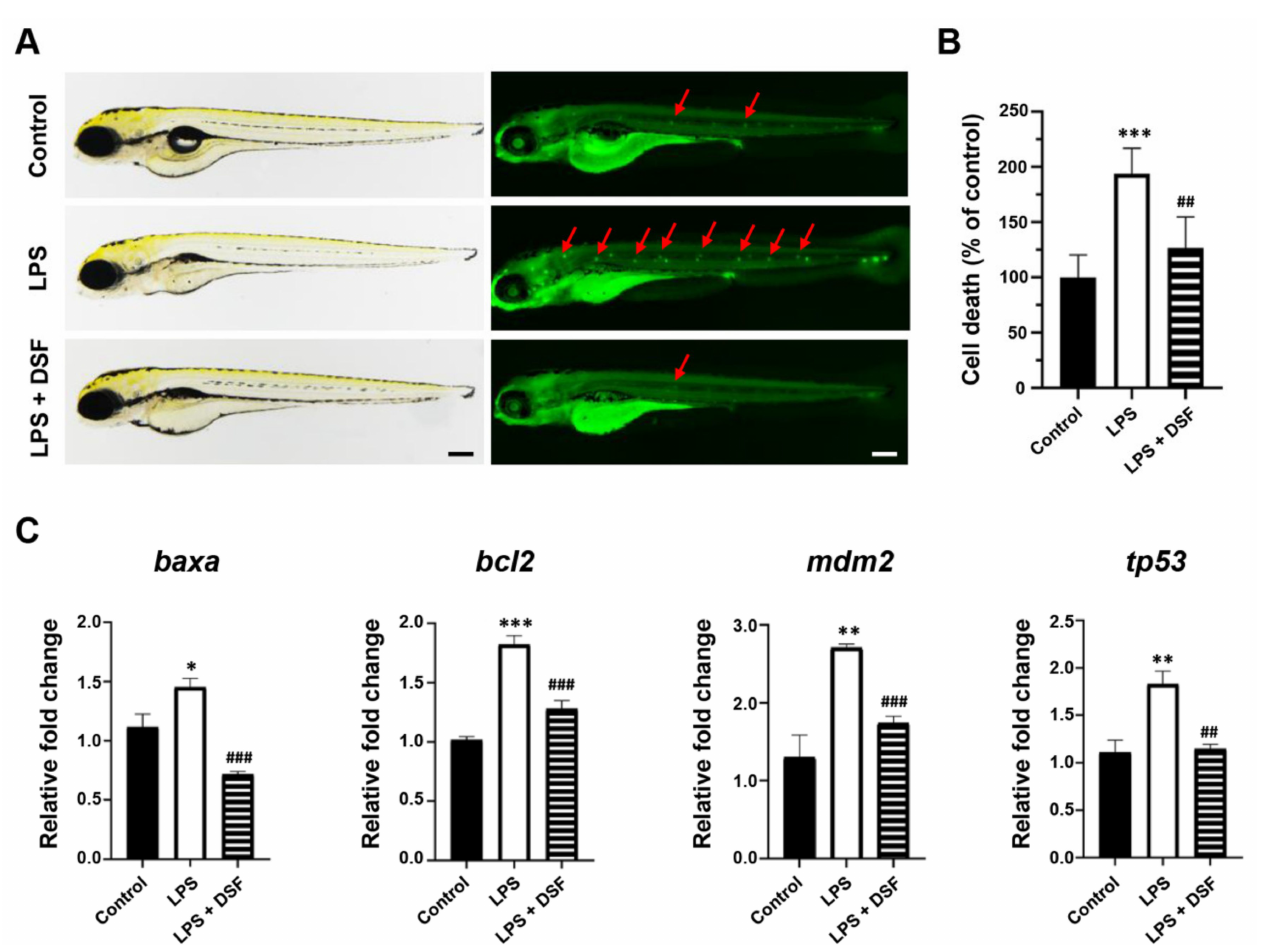
Figure 5. DSF reduced LPS-induced apoptosis in zebrafish embryos. ( A ) The prevalence of apoptosis in zebrafish embryos was detected with fluorescent dye AO staining; red arrows indicate the apoptotic cells. ( B ) The fluorescence intensity was quantified for individual zebrafish using ImageJ analysis. ( C ) The relative mRNA expression levels of apoptosis markers ( baxa , bcl2 , mdm2 , and tp53 ) were measured with qRT-PCR. Data are represented as mean ± S.D. * p < 0.05, ** p < 0.01, *** p < 0.001 vs. control group; ## p < 0.01, and ### p < 0.001 vs. LPS group. Scale bar, 200 µ